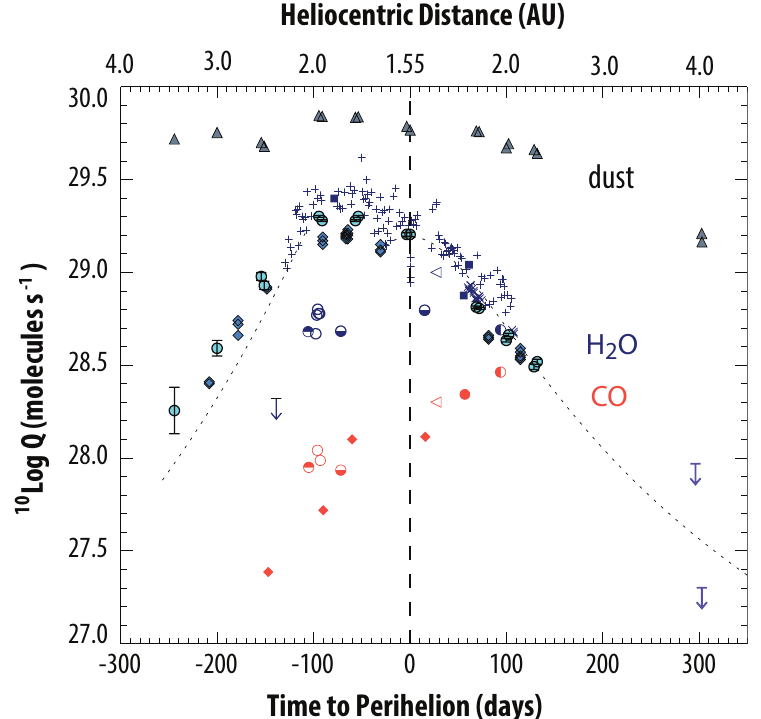
Figure 4. Activity evolution of comet C/2009 P1 (Garadd), taken from [16]. H 2 O production rates (blue symbols) peak ∼ 100 days pre-perihelion, while CO (red symbols) continues to increase even after perihelion. Perihelion is indicated by a vertical dashed line. Water production rates derived using imaging with large apertures ( Swift /UVOT—cyan circles [16]; SOHO/SWAN—blue pluses [42] are much larger than those derived from observations with slit-based instruments (VLT/CRIRES— blue open circles and downward arrow pre-perihelion—[39]); Keck/NIRSPEC—blue lower half filled circle [40]; Keck/NIRSPEC and IRTF/CSHELL—blue upper half circle [41]. For a complete attribution of all measured production rates, see